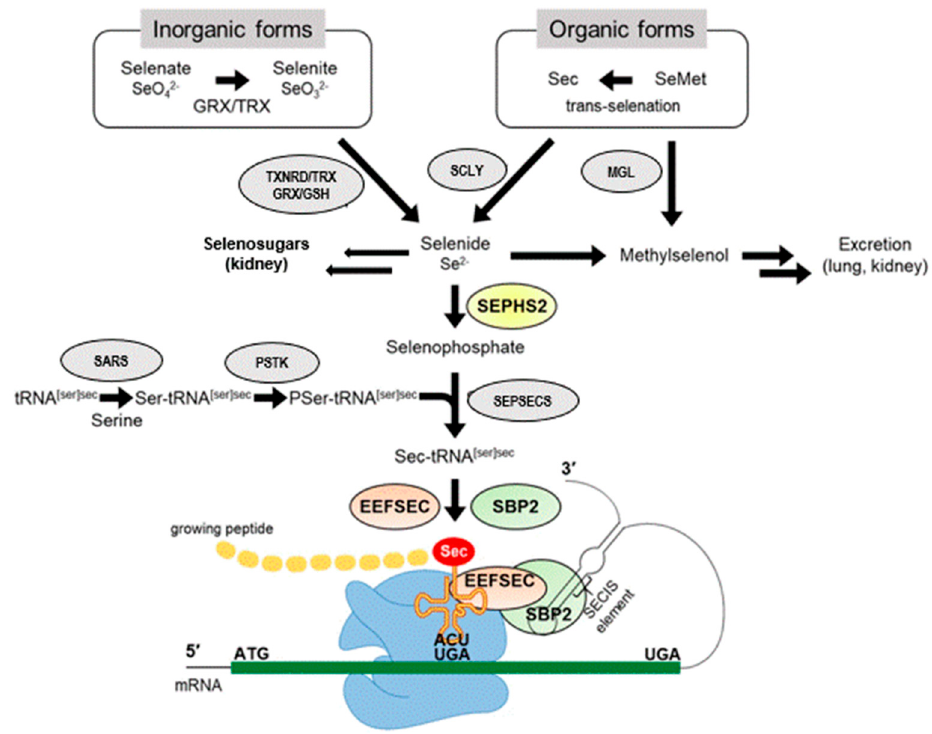
Figure 3. Nutritional sources of selenium and their utilization for biosynthesis of selenocysteine- containing proteins. Abbreviations: SeMet, selenomethionine; Sec, selenocysteine; GRX, glutathione reductase; TRX, thioredoxin; TXNRD, thioredoxin reductase; GSH, glutathione; MGL, methionine gamma-lyase; SCLY, selenocysteine lyase; SEPHS2, selenophosphate synthetase 2; SARS, seryl- tRNA synthetase; PSTK, phosphoseryl(Sep)-tRNA kinase; SEPSECS, Sep-tRNA:Sec-tRNA synthase; EEFSEC, Sec-specific eukaryotic elongation factor; SBP2, SECIS binding protein 2. Adapted from [69], Kang D, et al.